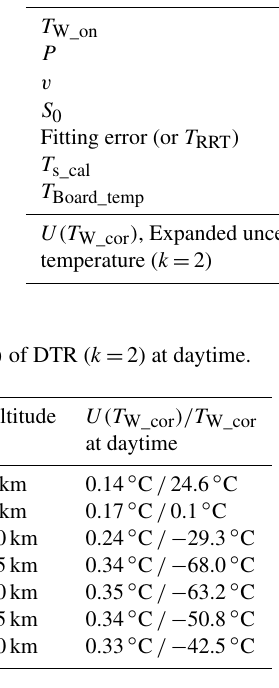
Table 4. Uncertainty budget on radiation-corrected temperature by DTR in daytime at an altitude of 30km. Uncertainty factor Condition Unit Uncertainty Contribution to uncertainty at 30km ( k = 2) of radiation-corrected temperature ( k = 2) T W_on − 41 . 5 ◦ C 0.23 0.000 ◦ C P 12.6 hPa 0.3 0.004 ◦ C v 6.1 ms − 1 960